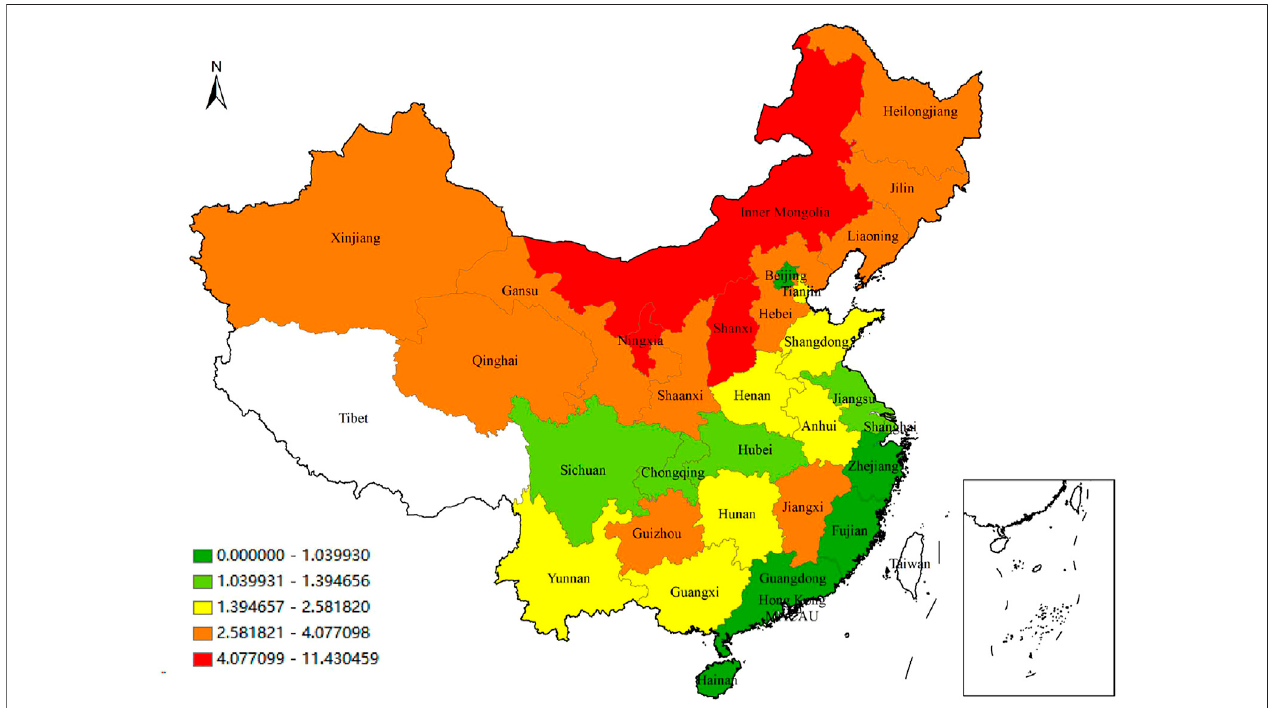
FIGURE 1 | Distribution map of carbon emission intensity in